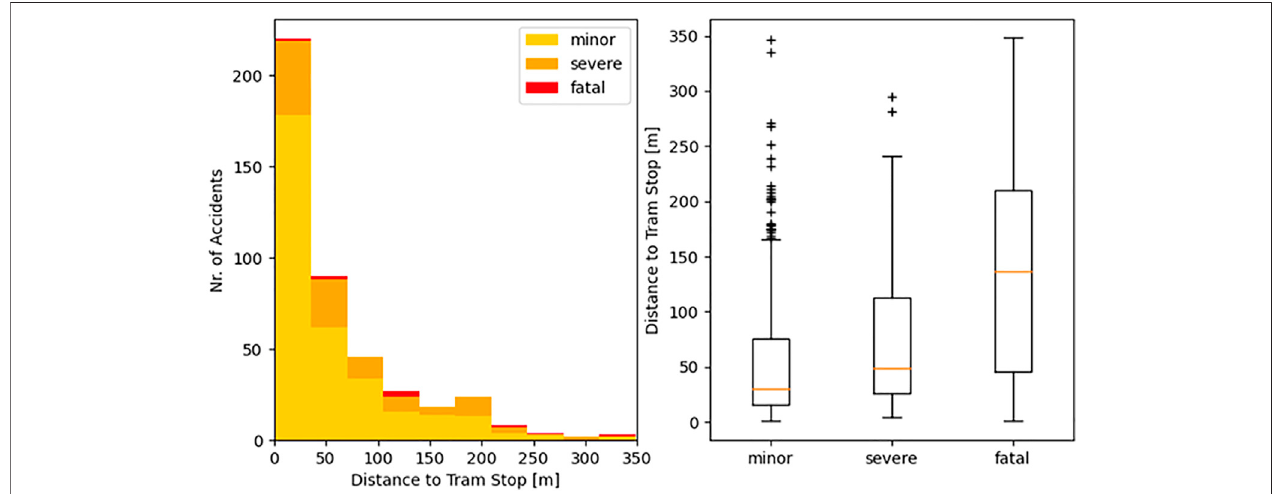
FIGURE 4 | Distance distribution between accident-tram stops in the city of Vienna (443 cases during the period 2014 – 2020), highlighted according to severity.